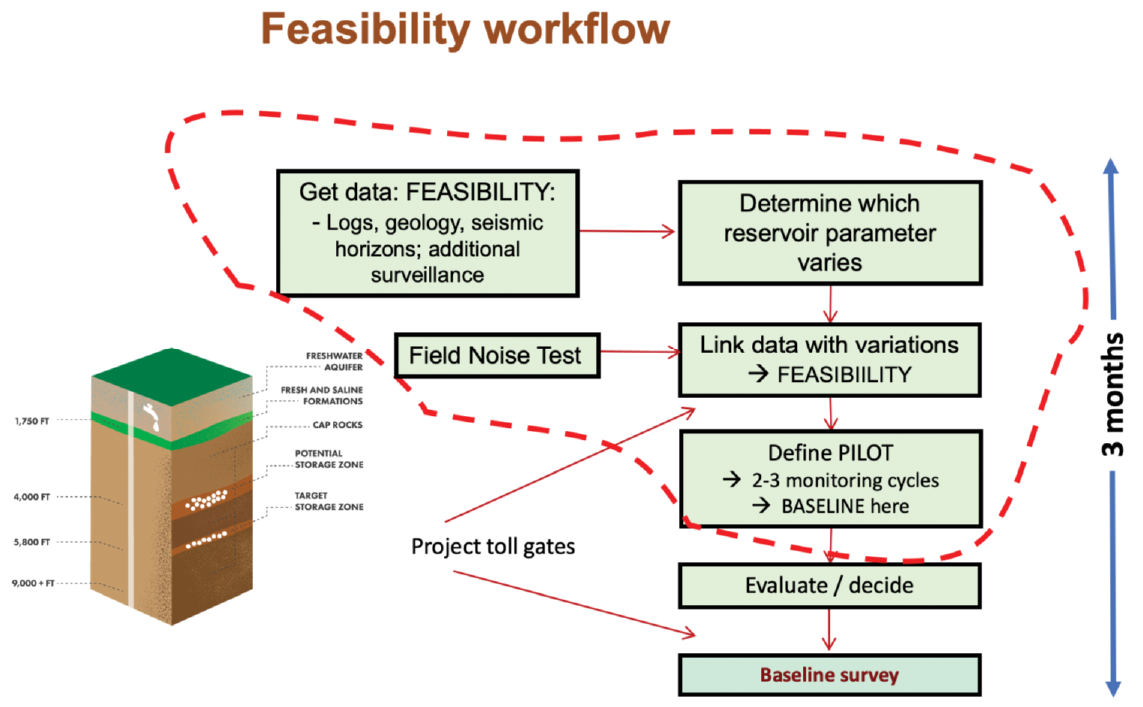
Figure 4. Feasibility workflow of a typical electromagnetic reservoir monitoring project including on-site noise test. The major task is in each block.